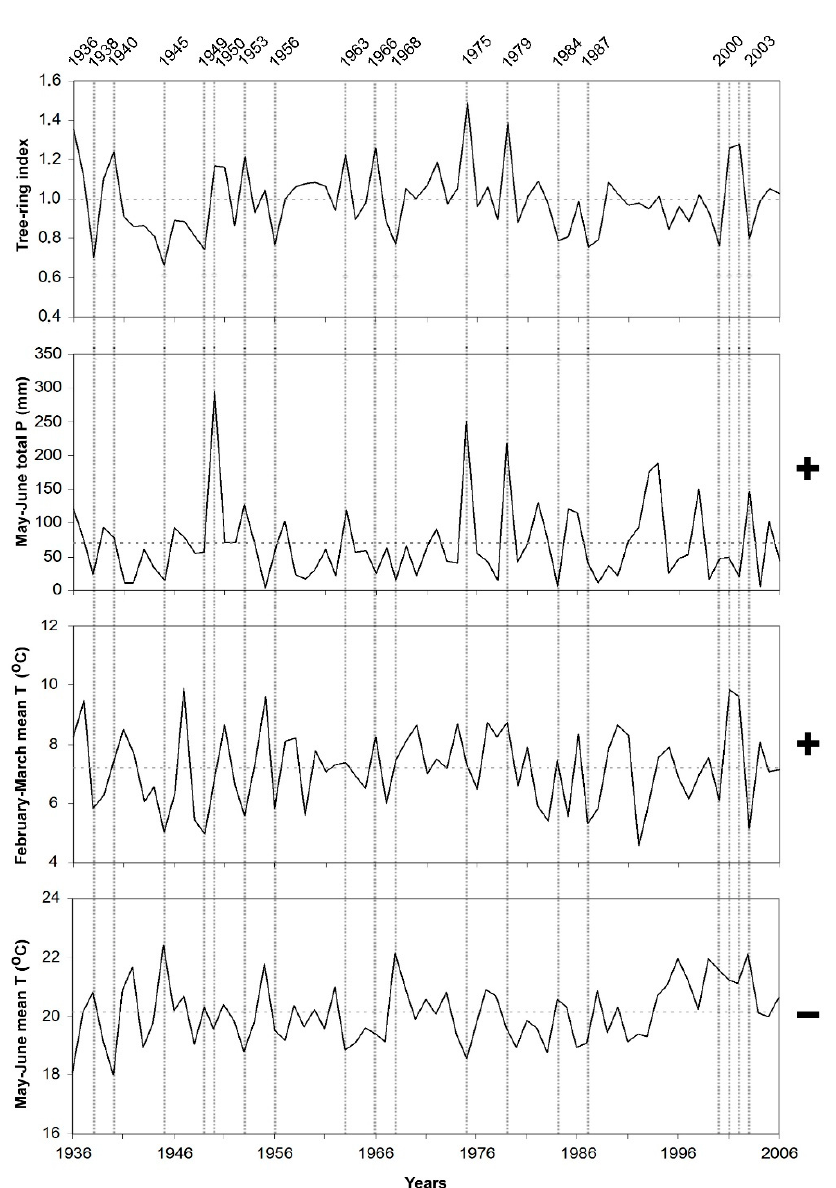
Figure 4. Residual chronology of lower limit of black pine on the south slope (AGA site) and limiting climate factors, which are May–June total precipitation, February–March and May–June mean temperature in the period of 1936–2006. Vertical dashed lines represent pointer years, which have very narrow and large ring formation years. Horizontal dashed lines represent the average value. “ + ” and “ − ” represent the positive and the negative correlation between climate factors and tree-ring width, respectively.